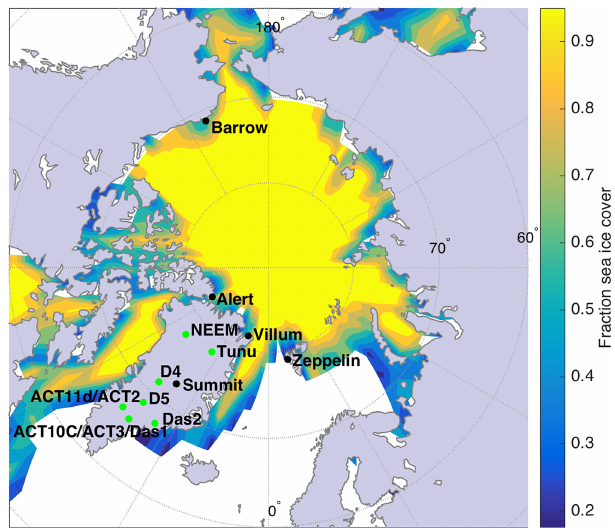
Figure 1. Map of the Arctic region showing locations of aerosol sampling stations (black circles) and ice cores (green circles) used in this study. Contoured shading is mean February fractional sea ice coverage for 1991–1999, as prescribed in